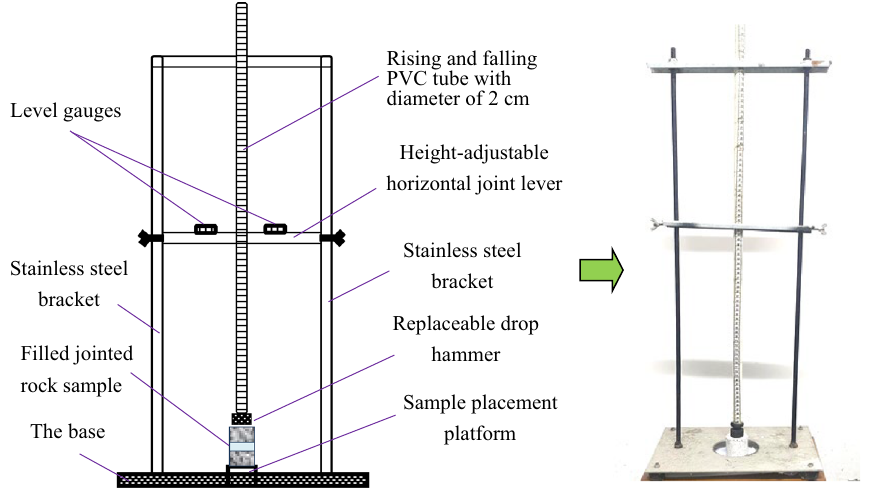
Figure 2. Self-made falling weight impact device.